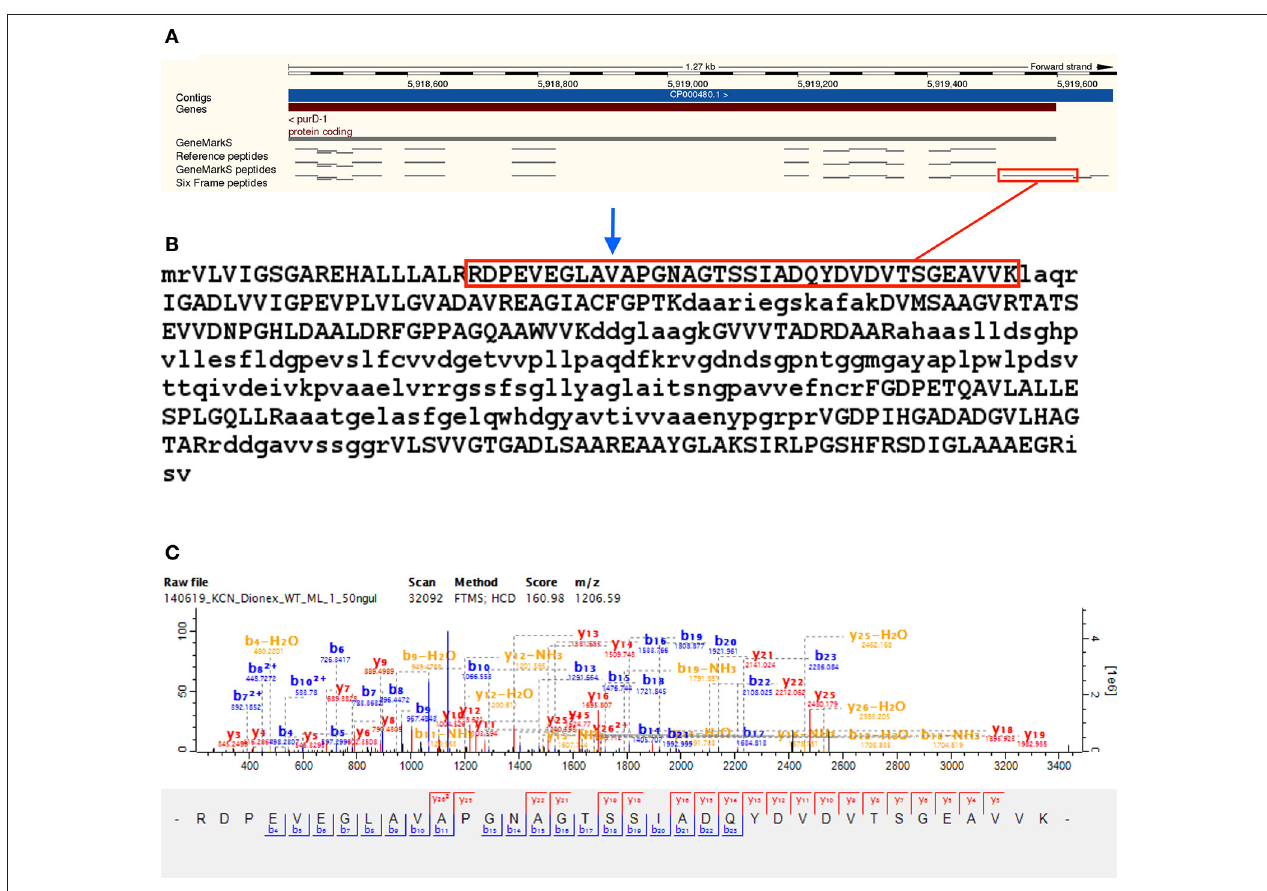
FIGURE 5 | Upstream gene model modification — A0R4J1. Shows evidence for gene model modification of the Reference protein A0R4J1 (Phosphoribosylamine–glycine ligase) by N-terminal extension, with the N-terminal of three identified peptides extending upstream of the predicted TSS, extending the N-terminal of the protein by 29 amino acids. The modified sequence is identical to the predicted protein I7GFT2 for the same strain (not included in the Reference proteome). Panel (A) shows the peptide RDPEVEGLAVAPGNAGTSSIADQYDVDVTSGEAVVK—highlighted in red—extending upstream of the annotated TSS along with two other peptides. Panel (B) shows the sequence of the modified gene model of A0R4J1, with the annotated TSS position indicated by the blue arrow. Panel (C) shows a representative MS/MS spectrum of RDPEVEGLAVAPGNAGTSSIADQYDVDVTSGEAVVK, identified from eight MS/MS spectra in the translated six frame database